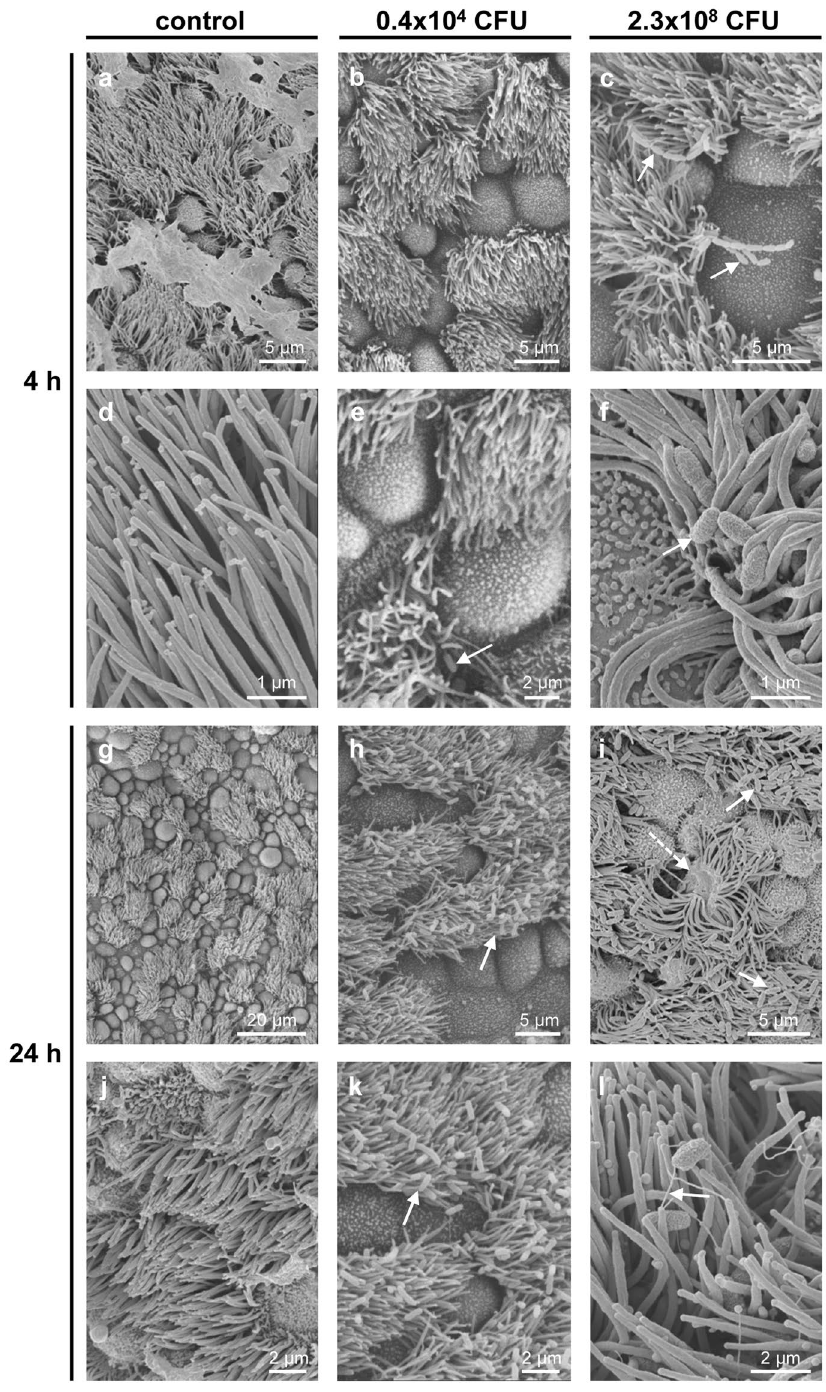
Figure 5. B. pseudohinzii (strain 3227) attaches to cilia and damages the epithelium in an in vitro -infection model. Tracheal explants were cultured for 24 h, with following addition of bacteria for 4 h or 24 h, and analysed by scanning electron microscopy. ( a , d ) Upon cultivation for 24 + 4 h without adding of bacteria, cilia are regularly orientated and no bacteria are visible. ( b , e ) The trachea was cultivation for 4 h in 1 ml medium with 0.4 × 10 4 CFU B. pseudohinzii . A single bacterium is seen attached to cilia ( arrow ). ( c , f ) Cultivation for 4 h with a higher dose of B. pseudohinzii (2.3 × 10 8 CFU). No obvious alterations of cilia or ciliated cells can be observed. Bacterial chains are attached to cilia ( arrows ). ( g , j ) Cultivation for 48 h without adding of bacteria. Ciliated cells are intact and cilia show no signs of damage. ( h , k ) Cultivation for 24 h with 0.4 × 10 4 CFU B. pseudohinzii . ( i , l ) Cultivation for 24 h with a higher dose of B. pseudohinzii (2.3 × 10 8 CFU). Increased numbers of bacteria are attached to cilia ( arrows ), cilia look flattened. Single ciliated cells are massively damaged ( dotted arrow